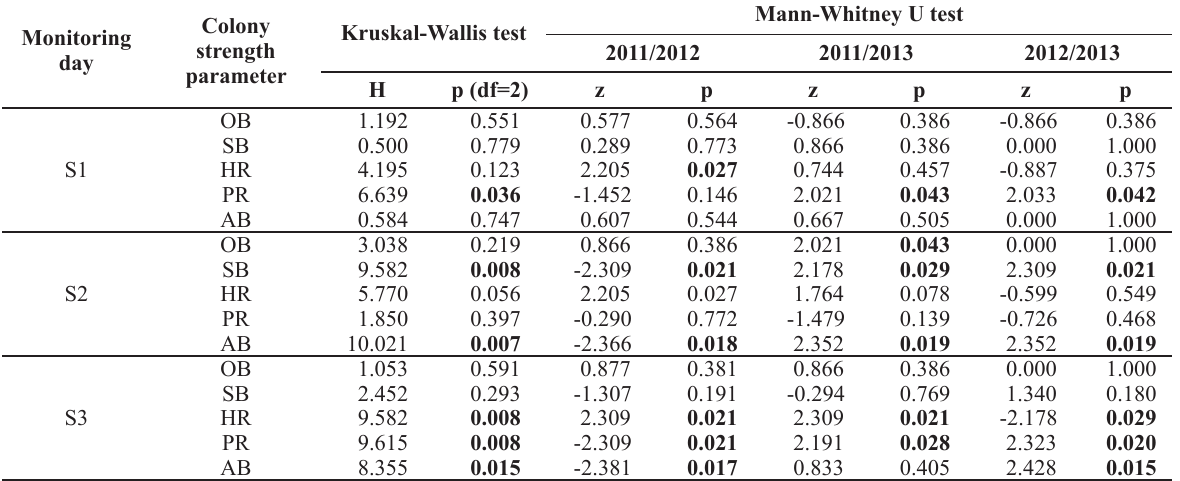
Differences in colony strength parameters in three consecutive years in control honey bee